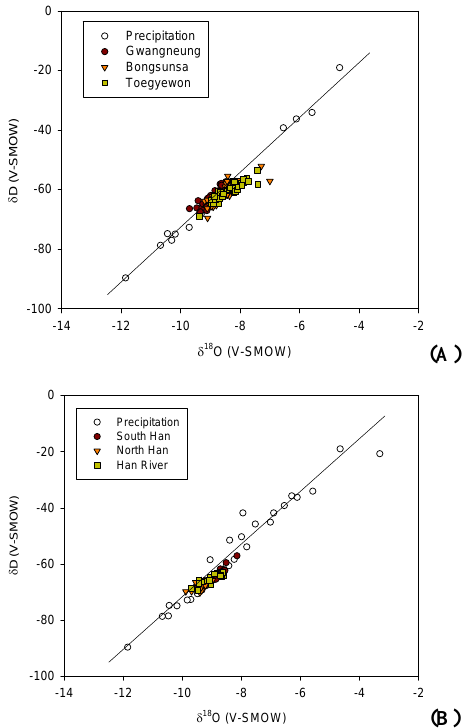
Fig. 3. Isotope composition of river waters (A) for small and (B) large catchments. Isotope composition of precipitation is from Gwangneung for the small catchments and from all three locations for the large